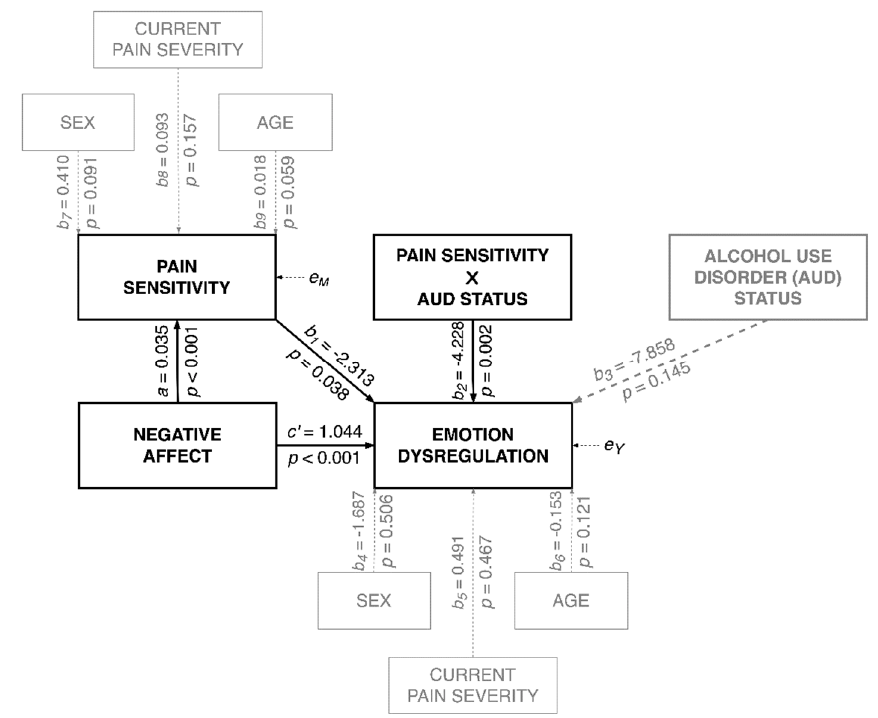
Figure 2. The moderated mediation model for emotional dysregulation.